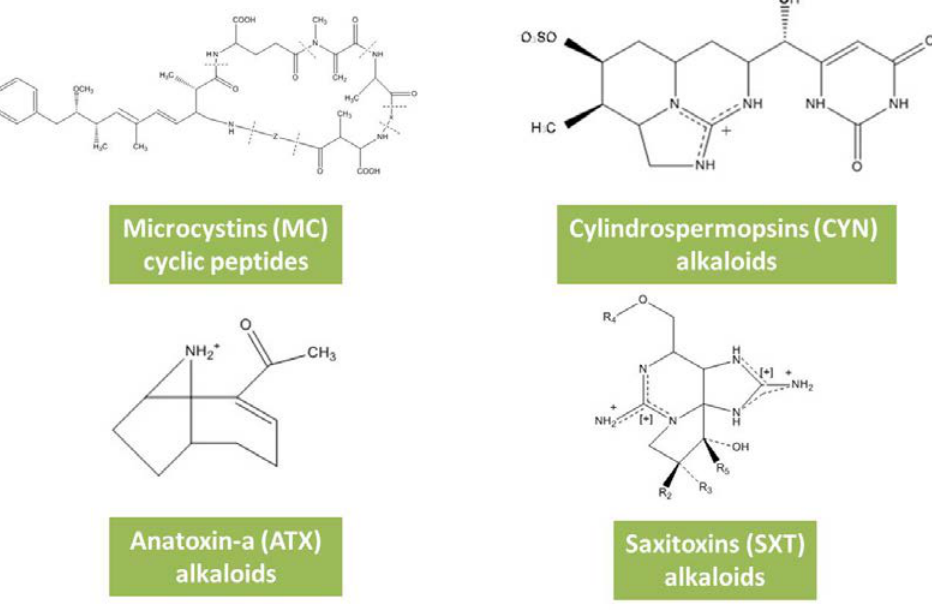
Figure 2. Chemical structure of cyanotoxins associated with CyanoBlooms.